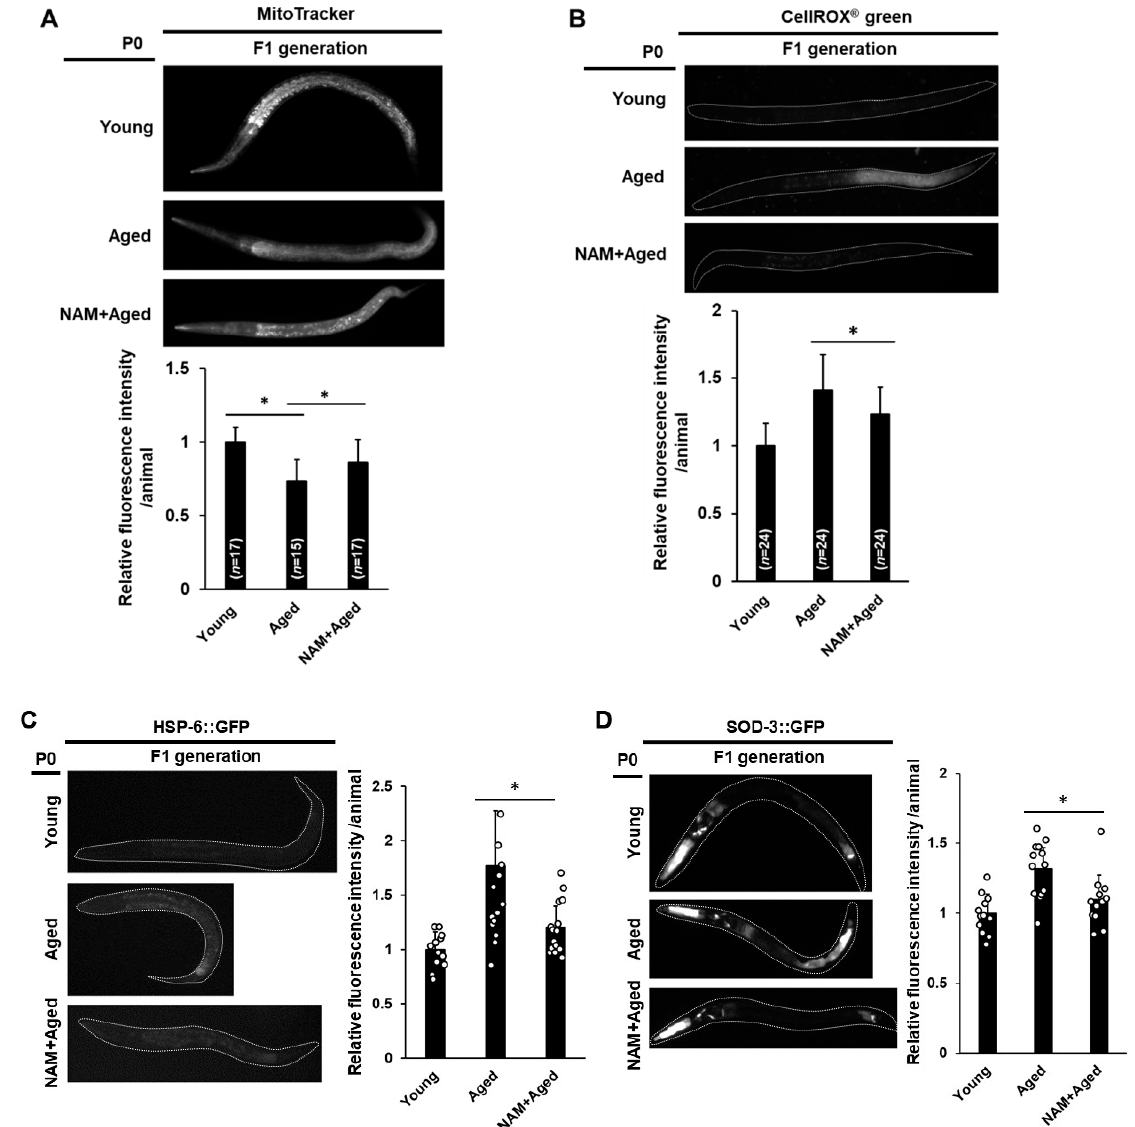
Figure 4. Mitochondrial activity and oxidative stress responses in offspring produced by aged oocytes are improved by maternal nicotinamide (NAM) supplementation in Caenorhabditis elegans : ( A ) Comparison of mitochondrial activity in the F1 generation produced by young, aged, and NAM+aged mothers using MitoTracker staining. The graph shows the relative levels of mitochondrial activity by ImageJ analysis. Error bars represent standard deviation (SD). *, p < 0.05 (one-way ANOVA with Tukey’s post hoc test); ( B ) Comparison of mitochondrial reactive oxygen species (ROS) levels in the F1 generation produced by young, aged, and NAM+aged mothers using CellROX Green staining. The graph shows the relative levels of mitochondrial ROS by imageJ analysis. Error bars represent SD. *, p < 0.05 (one-way ANOVA with Tukey’s post hoc test); ( C , D ) The F1 generation of HSP-6::GFP and SOD-3::GFP transgenic animals produced by young, aged, and NAM+aged mothers, and respective fusion proteins were observed under fluorescence microscopy and quantified using ImageJ (each condition, n = 20). Error bars represent SD. *, p < 0.05 (one-way ANOVA with Tukey’s post hoc test).